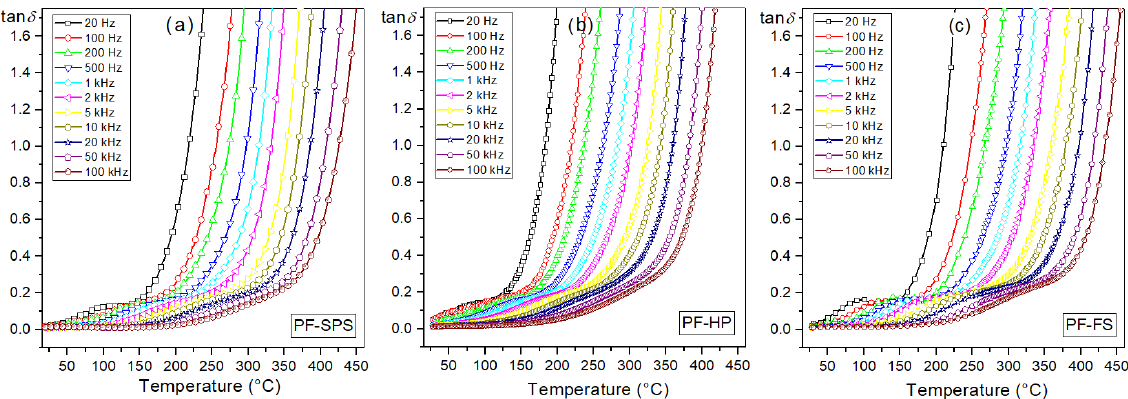
Figure 9. Temperature dependencies of dielectric loss factor tan δ for the PF multiferroic composites (heating): PF-SPS ( a ), PF-HP ( b ), and PF-FS ( c ).